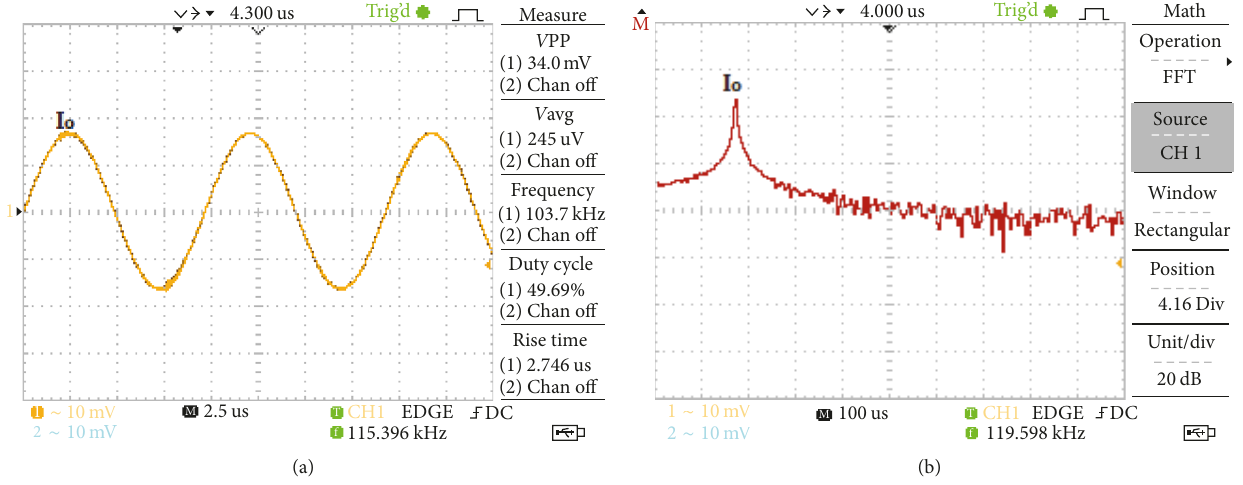
Figure 8: Measurement of output current and its spectrum at 𝑓 0 = 100